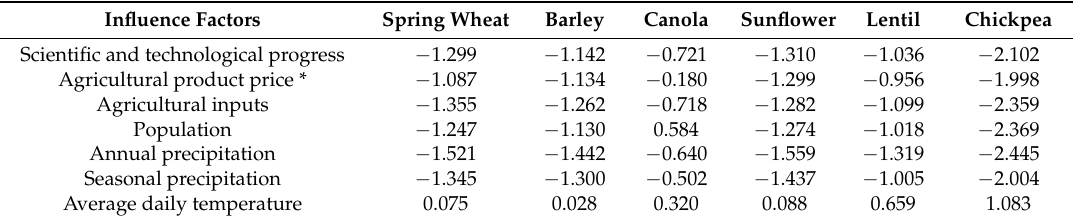
Table 3. Path coefficient analysis between grain yield-based water footprints (WFs) and their influencing